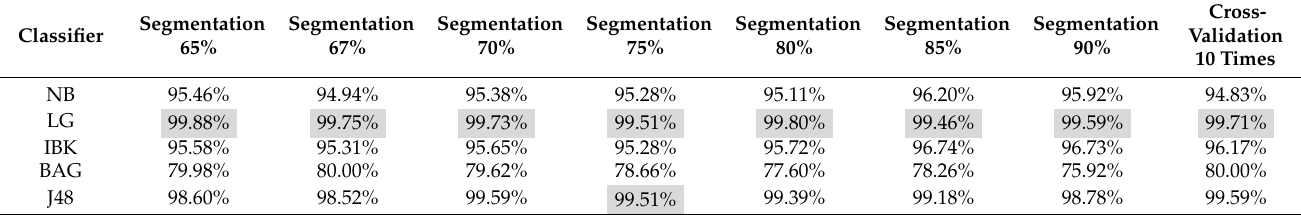
Table 11. The classifier accuracy of no-feature selection for 1964 normal and 491 bankrupt companies (4:1). Classifier